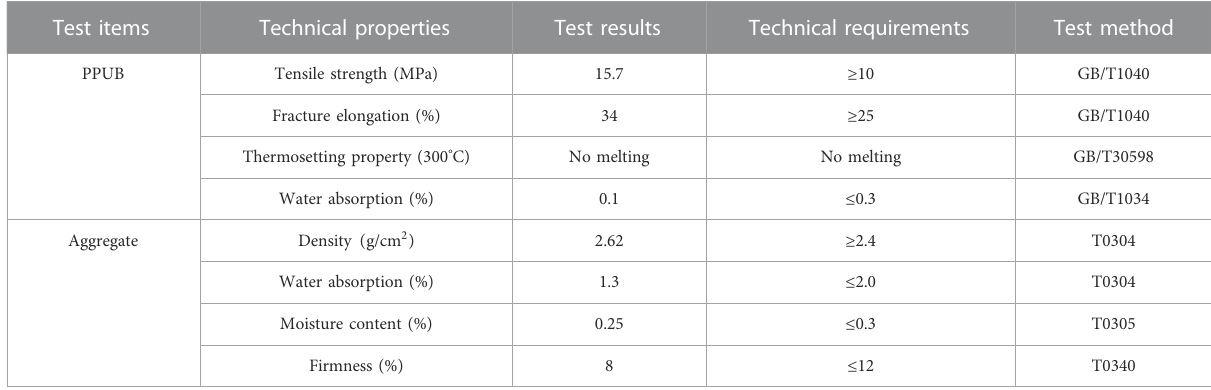
TABLE 1 Technical properties of the PPUB and the aggregate.